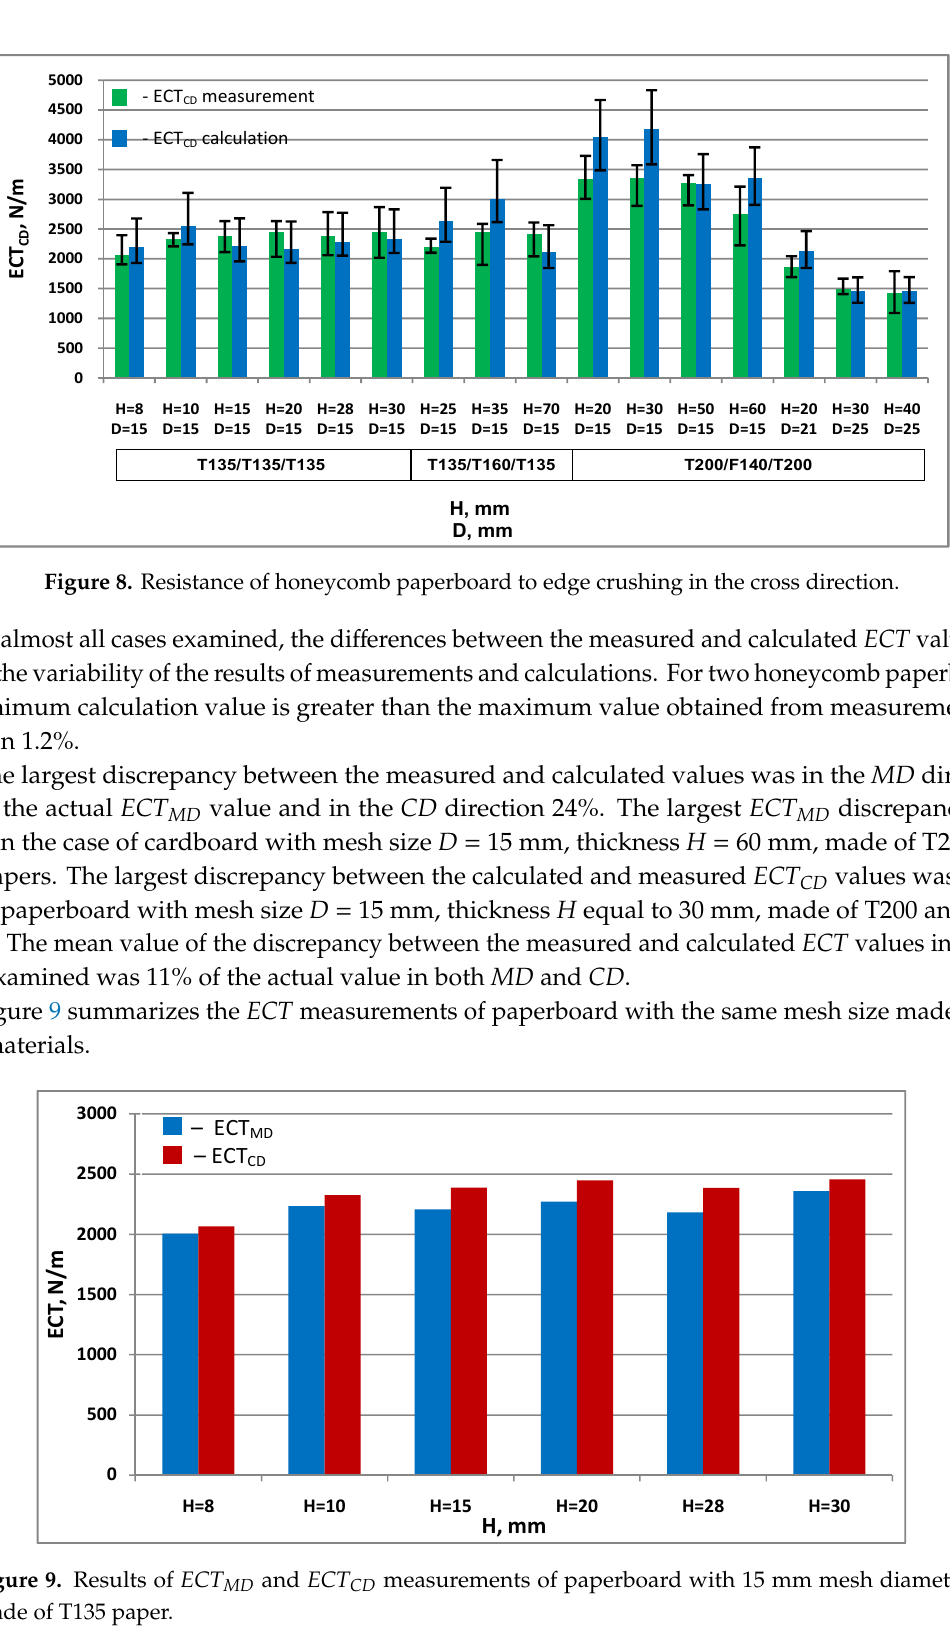
Figure 7. Resistance of honeycomb paperboard to edge crushing in the machine direction.